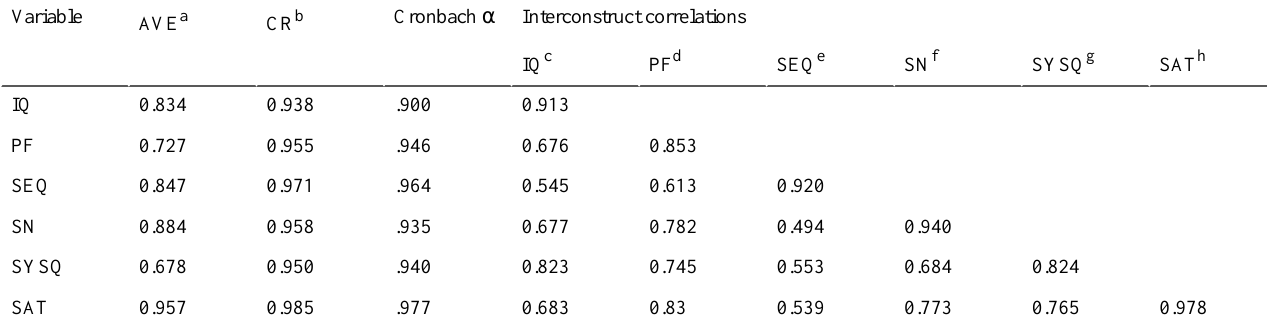
Table 3. Scale properties